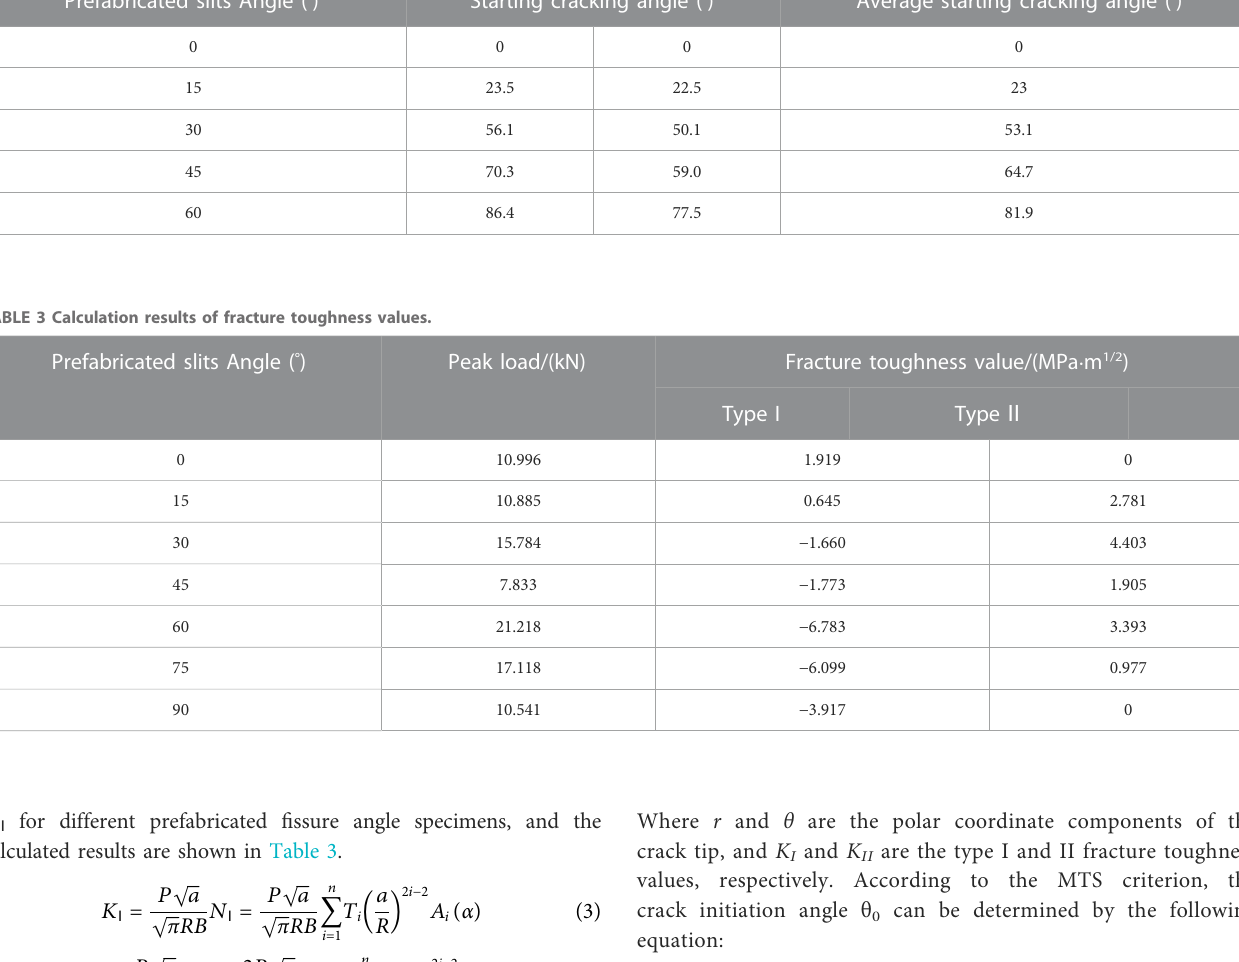
TABLE 2 Prefabricated fi ssure tip starting angle. Prefabricated slits Angle ( ° )